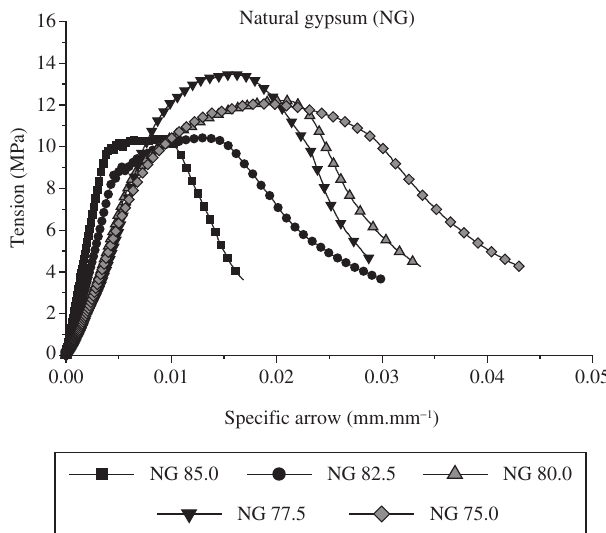
Figure 7. Strain displacement curves of matrices made of natural